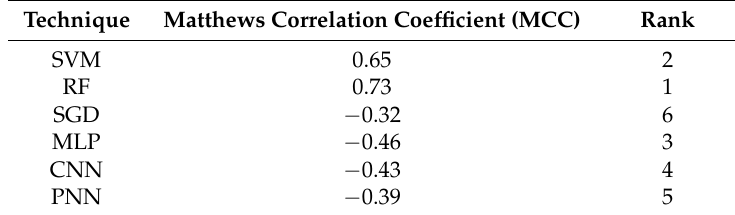
Table 3. MCC of SVM, RFC, SGD, MLP, CNN, and